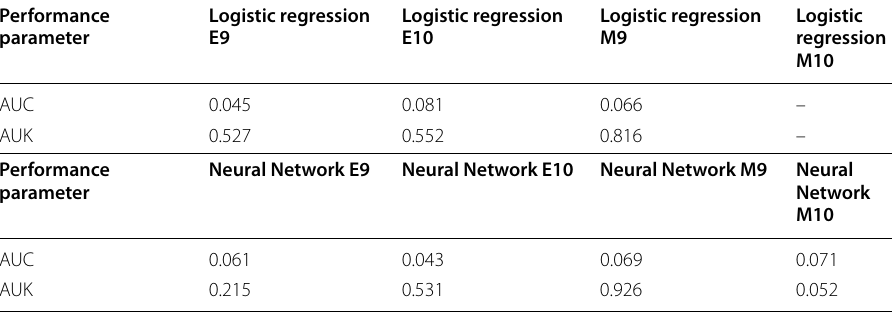
Table 6 Cost–benefit